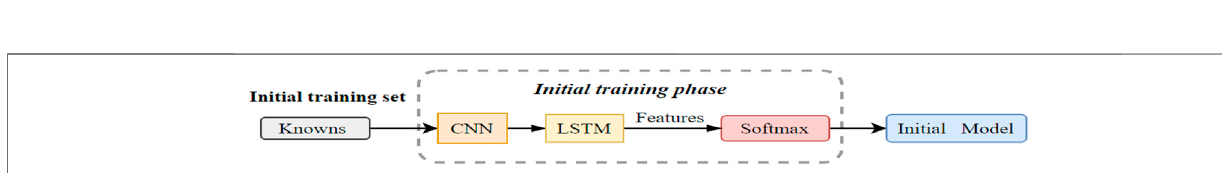
FIGURE 3 | The XFinder model in distributed machine learning. XFinder detecting unknown anomalies based on incremental learning. The unknown detector detects whether the input sample is known or unknown based on the initial training model, and the detected unknown sample is automatically labeled and added to the buffer to help update the network. The updated model is used for the next incremental training.